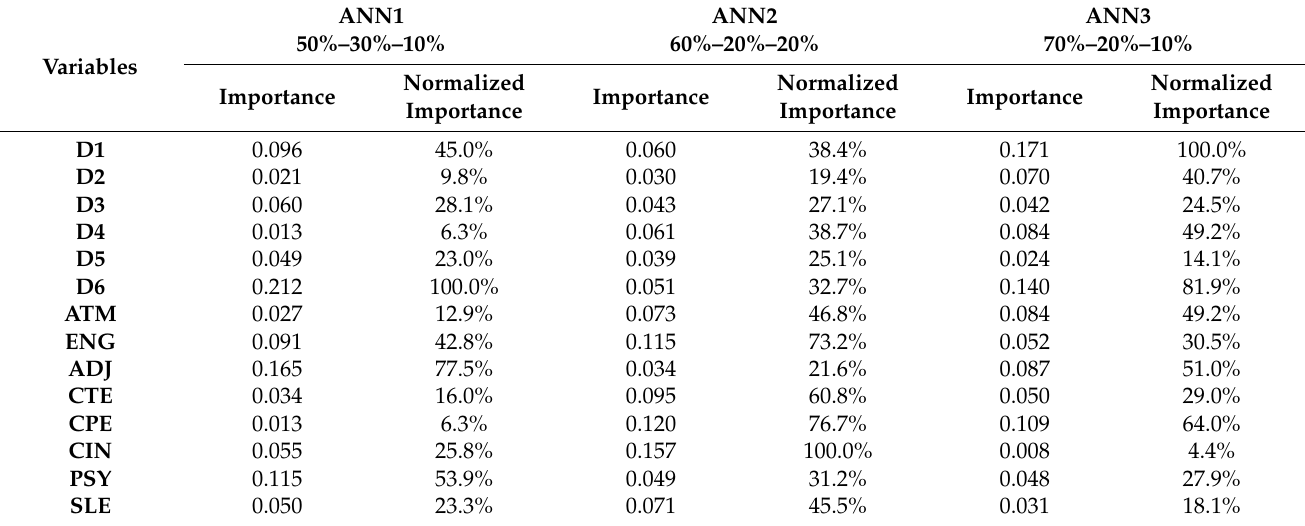
Table 8. Independent variable